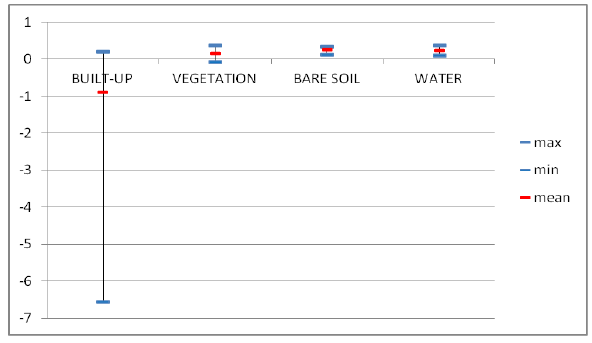
Figure 5. Index values (y-axis) for feature classes.